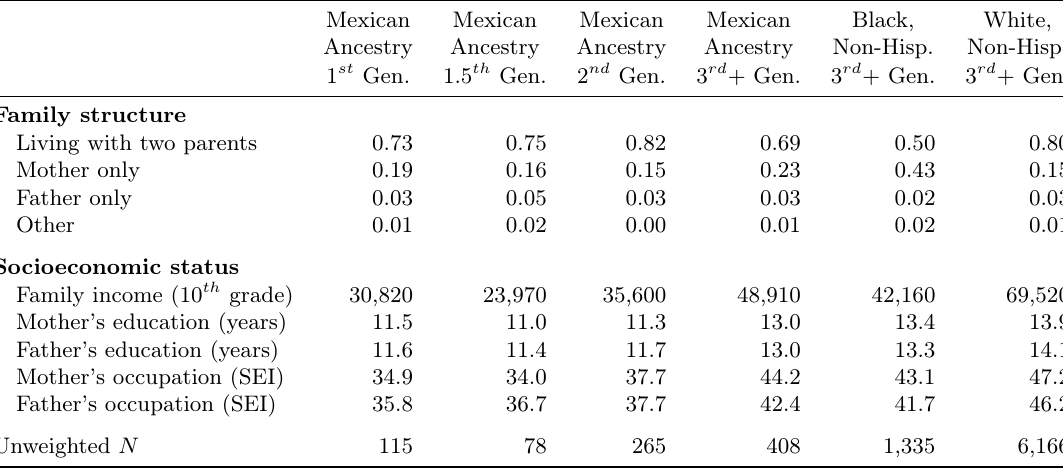
Table 4: Family Background Measures for the Six Focal